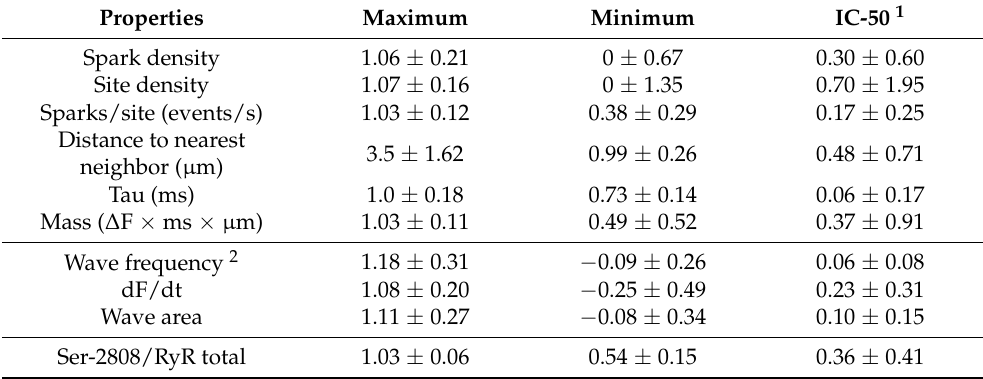
Table 3. Dose-Dependent Effects of R-Carvedilol on Intracellular Calcium Homeostasis.